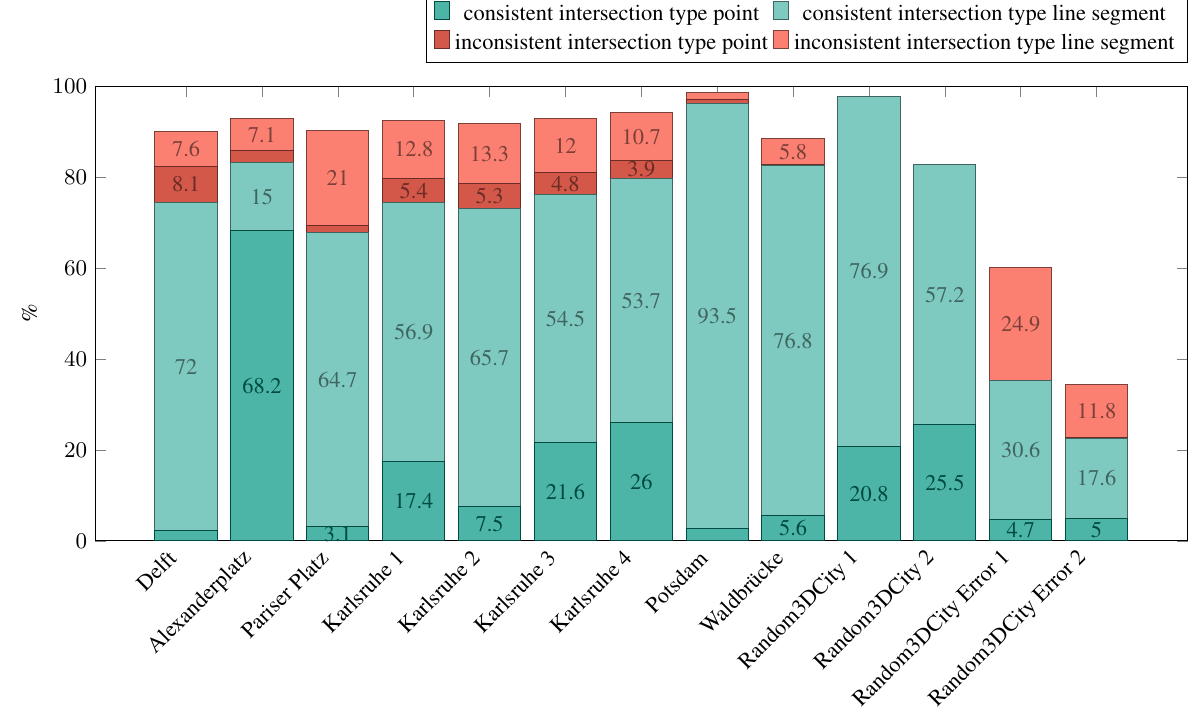
Figure 6. Topologically consistent and inconsistent configurations with point and line segment